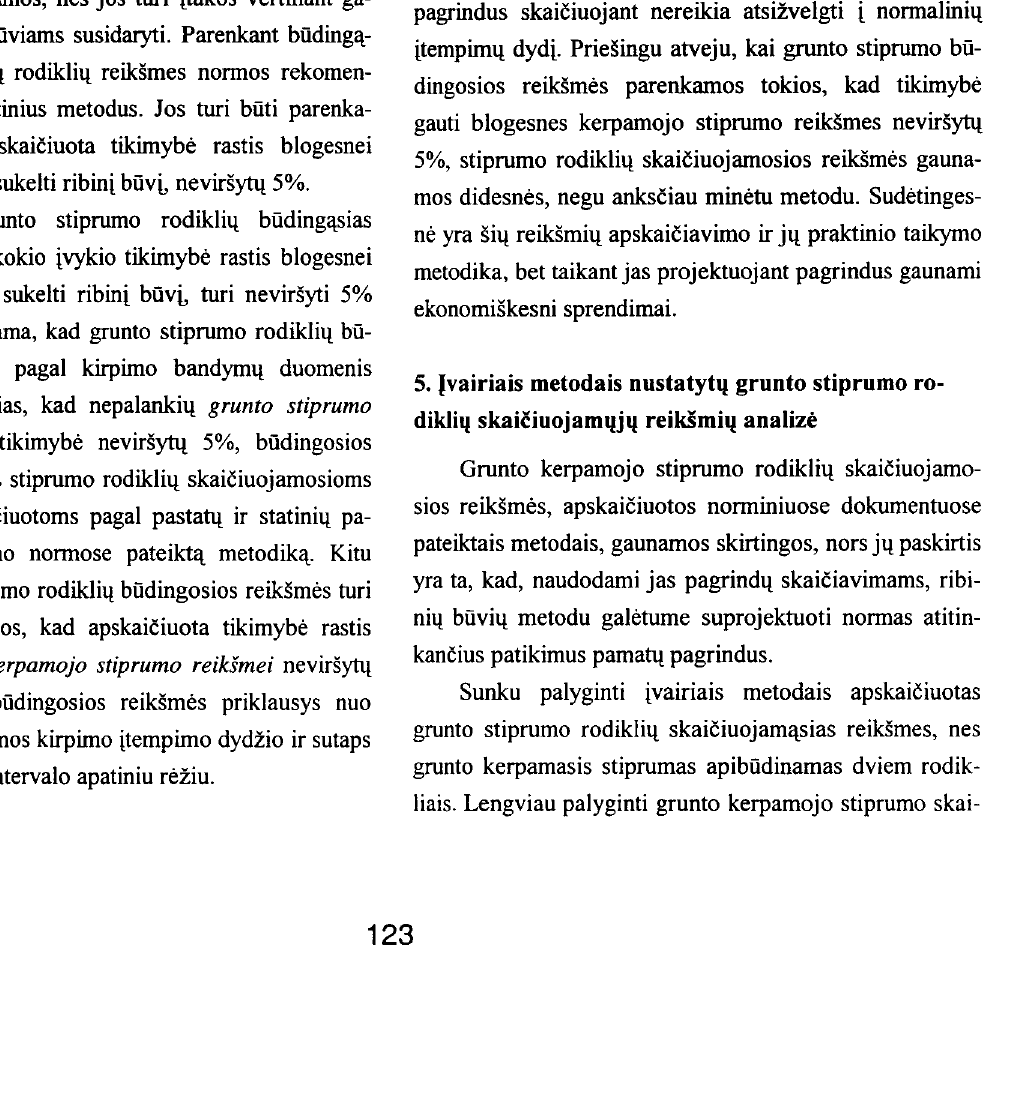
Fig 4. Shear test results. Design values calculated accor ding to Eurocode